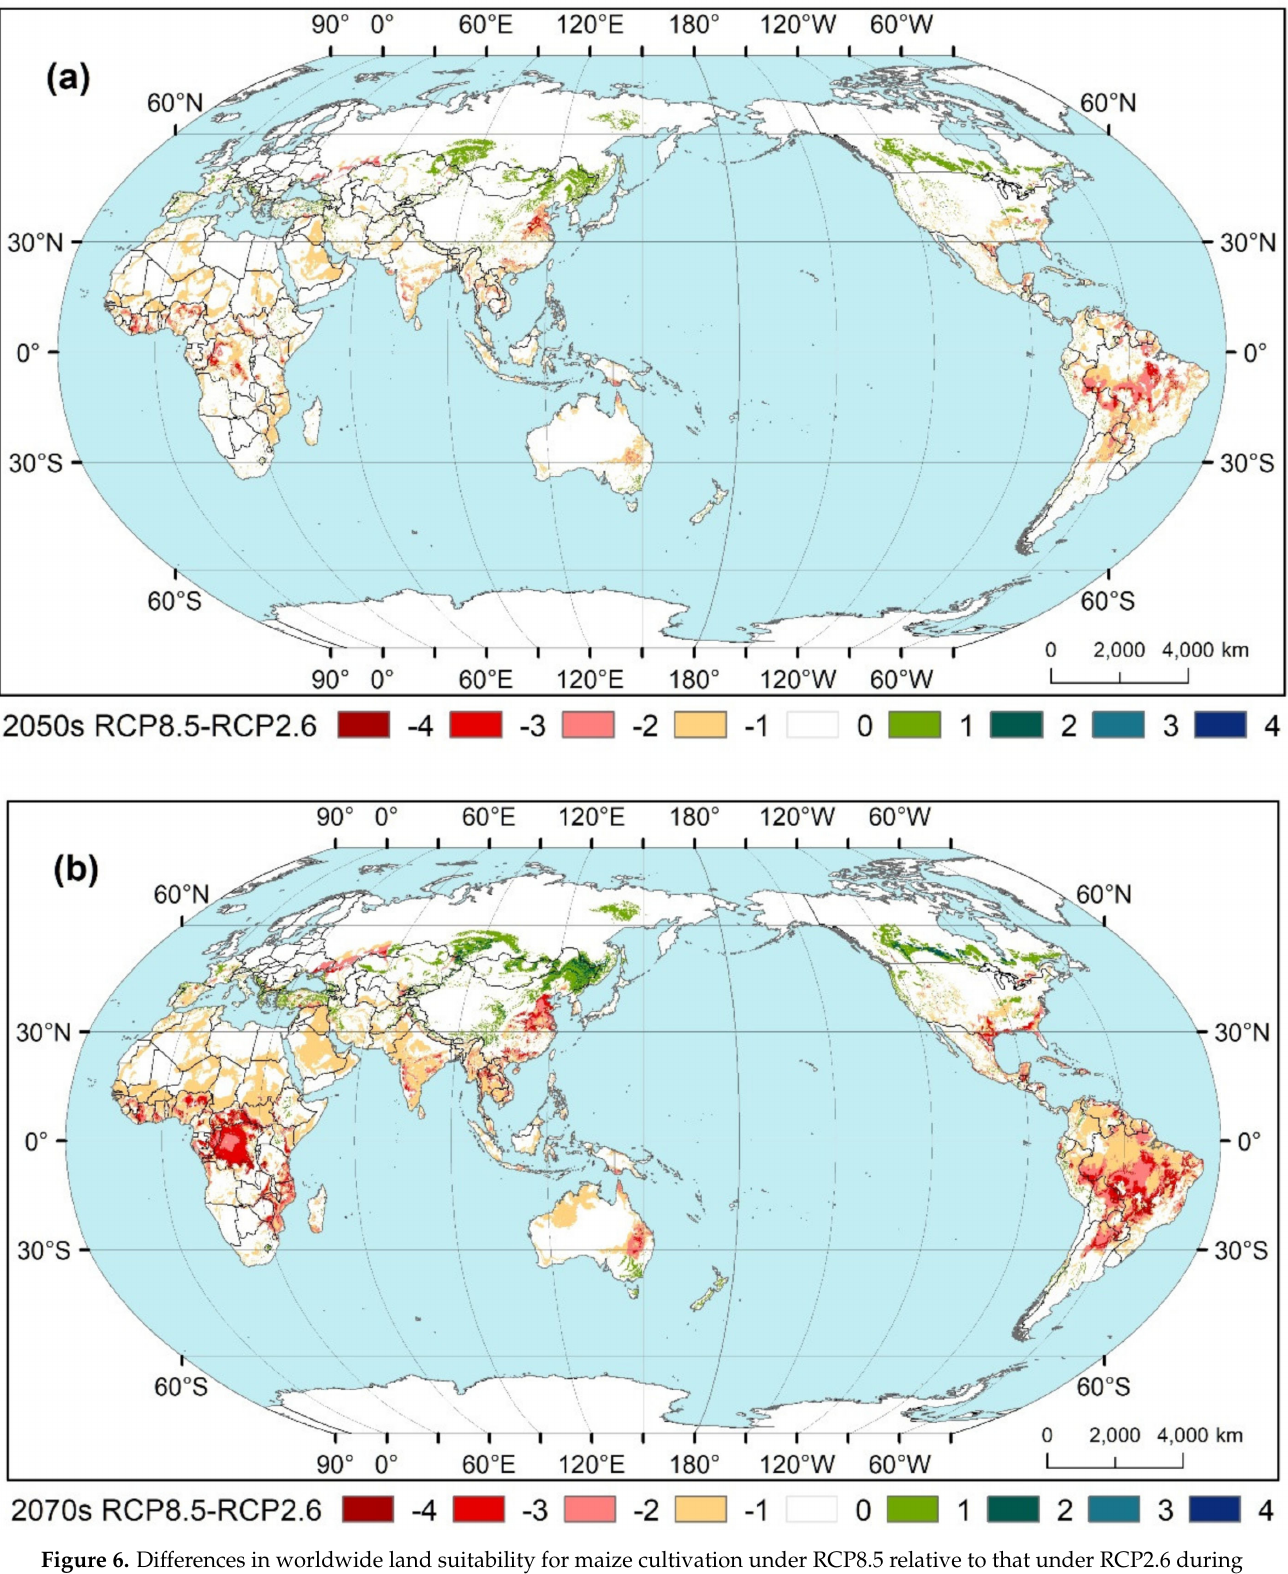
Figure 6. Differences in worldwide land suitability for maize cultivation under RCP8.5 relative to that under RCP2.6 during ( a ) 2050s (2041–2060) and ( b ) 2070s (2061–2080). RCP: representative concentration pathway. Note: The numbers indicate increases (positive) or decreases (negative) in the level of